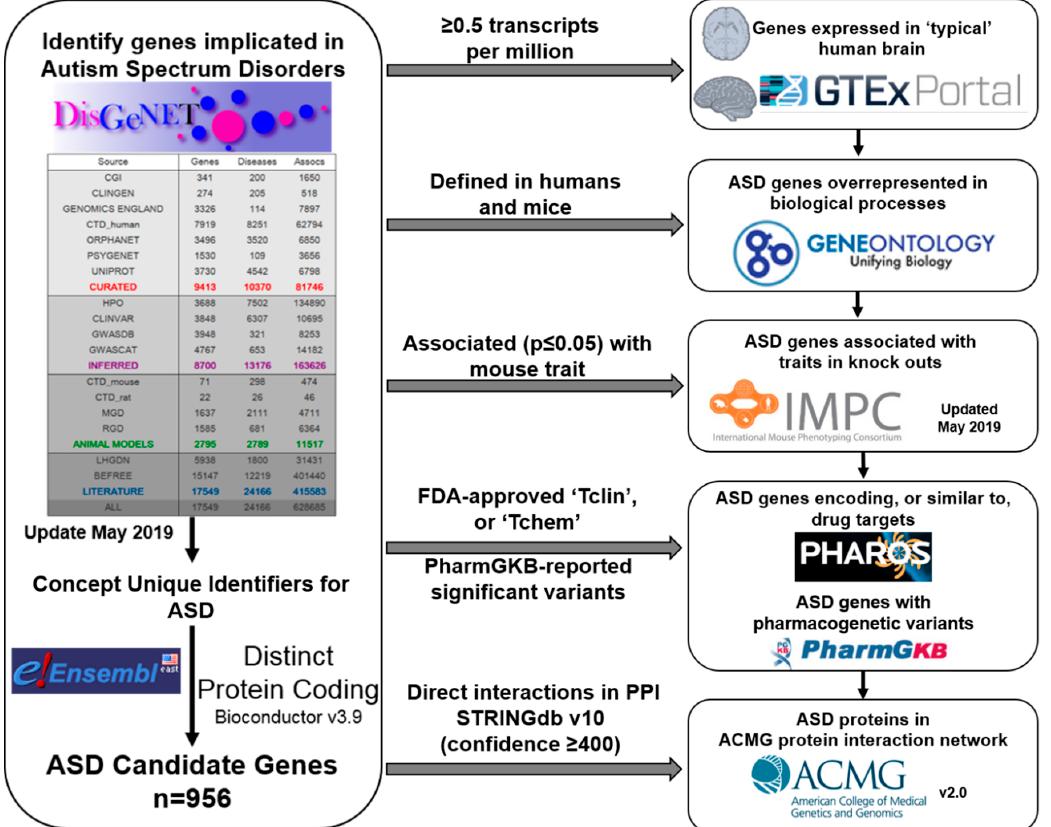
Figure 4. Candidate Gene Identification and Annotation Pipeline. All human protein coding genes defined in Ensembl, with evidence for influencing risk for concept unique identifiers reflecting Autism Spectrum Disorder (ASD) were identified from the DisGeNET resource which compiles evidence from all sources included in the corresponding table on the left side of the schematic. The initial list of 956 ASD candidate genes was then annotated using the publicly available resources included on the right side of the schematic, based on the criteria indicated above each arrow for each annotation step. TPM = transcripts per million, Tclin = FDA-approved compound targets, Tchem = molecules with properties similar to approved